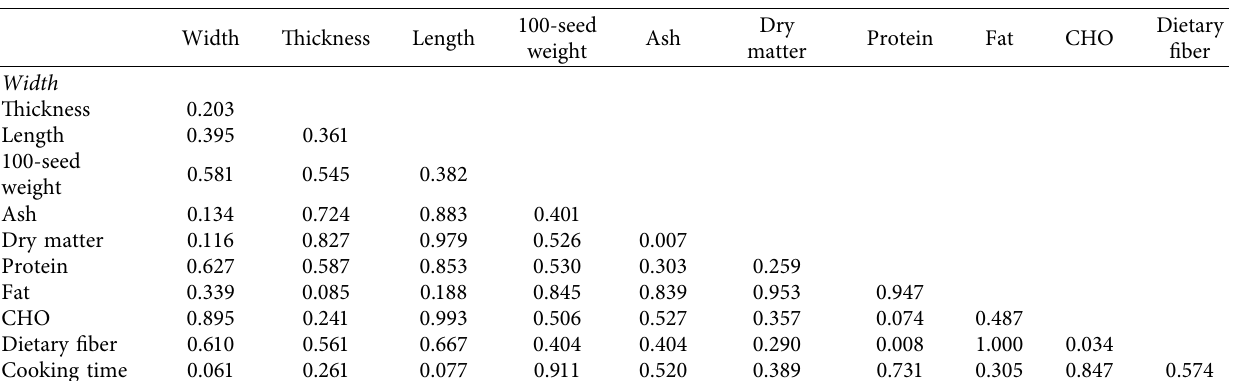
Table 5: p value of correlation